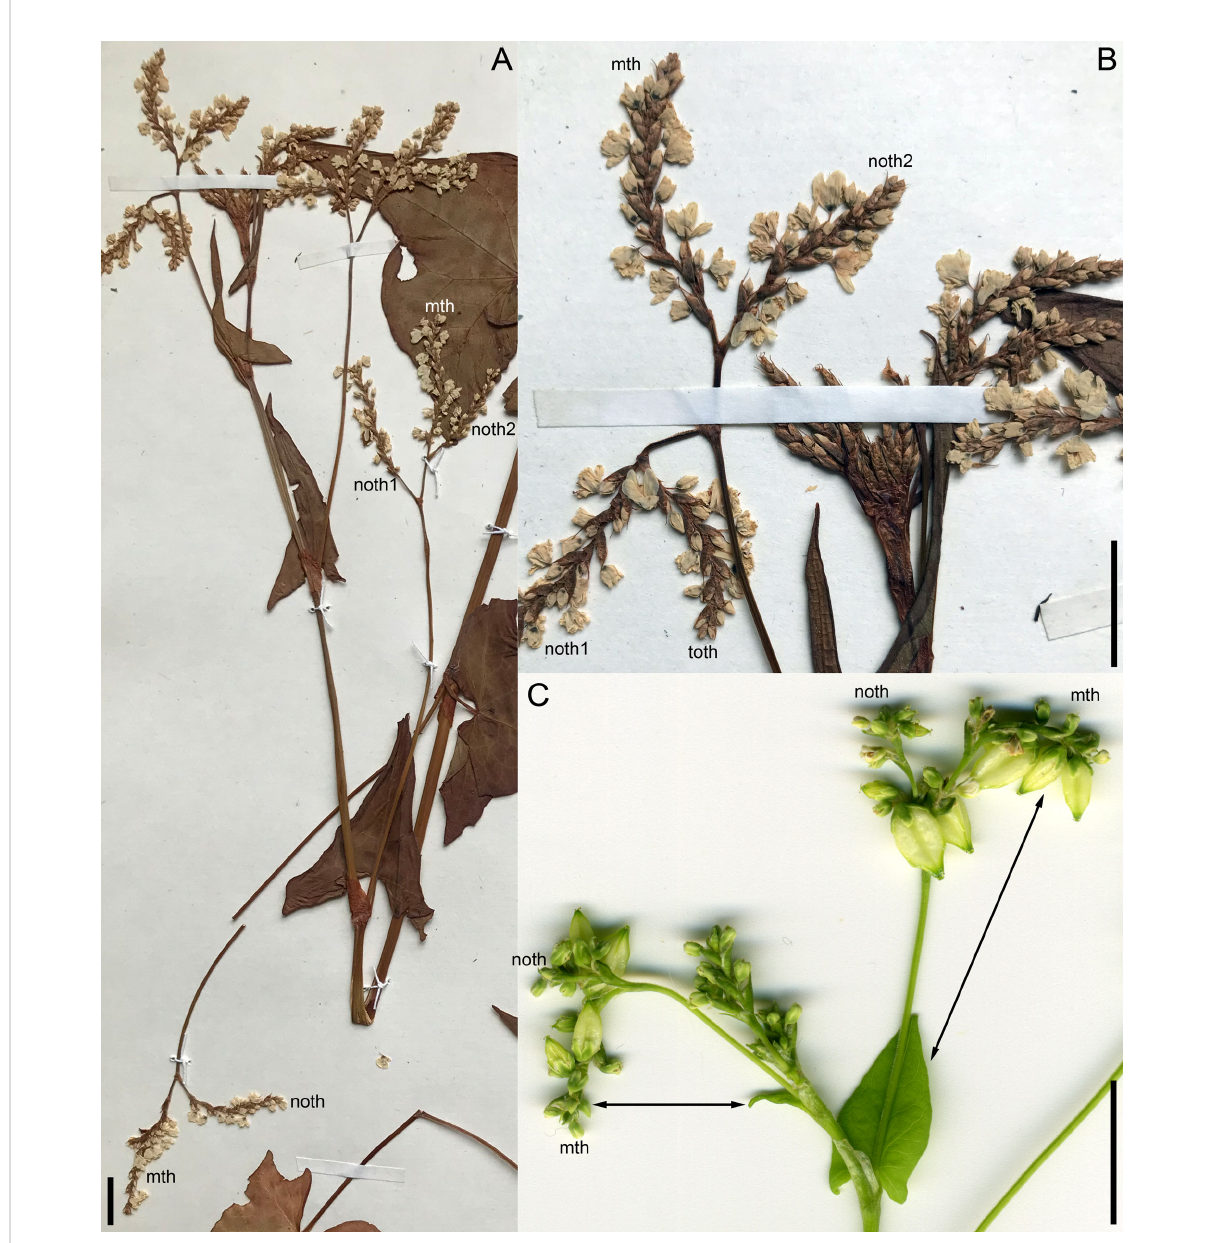
FIGURE 6 In fl orescence morphology. (A, B) Fagopyrum cymosum (herbarium specimen: China, Yunnan, Bartholomew et al., Sino-Amer. Bot. Exped. No. 1214 – MHA). (B) is a detail of (A) showing young branches near the apex of the main axis. A diagram of this specimen is in the Figure 5E. (C) Fagopyrum tataricum accession K17, distal part of in fl orescence. See Figure 5A, for complete diagram. Arrows show leaves subtending particular thyrses. mth, main thyrse of a lateral group; noth, next order thyrse of a lateral group; toth, third order thyrse of a lateral group; tth, terminal thyrse. Scale bars = 1 cm (A – C)